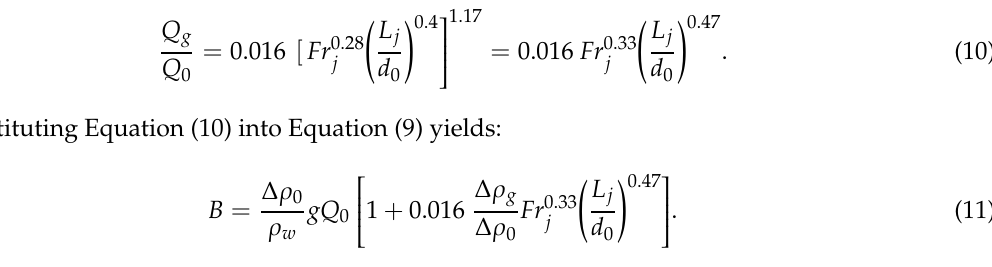
Figure 5. Data from [25,33] plotted in the new parameter space with 4 observations from this paper. Red dotted line shows the best fit line for values of (cid:4672) (3).